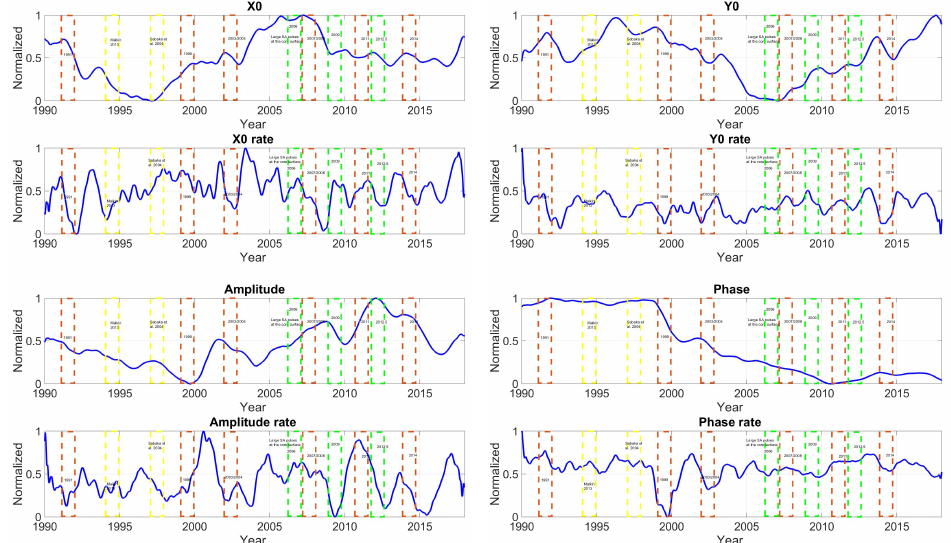
Figure 4. Time series of the normalized FCN offset, amplitude, and phase for the B 16 model. The dashed box indicates GMJ and magnetic secular acceleration pulse (SA) at the core surface. The red color shows the confirmed GMJ. The yellow shows the questionable SA of the GMJ. The green indicates the significant global SA of the